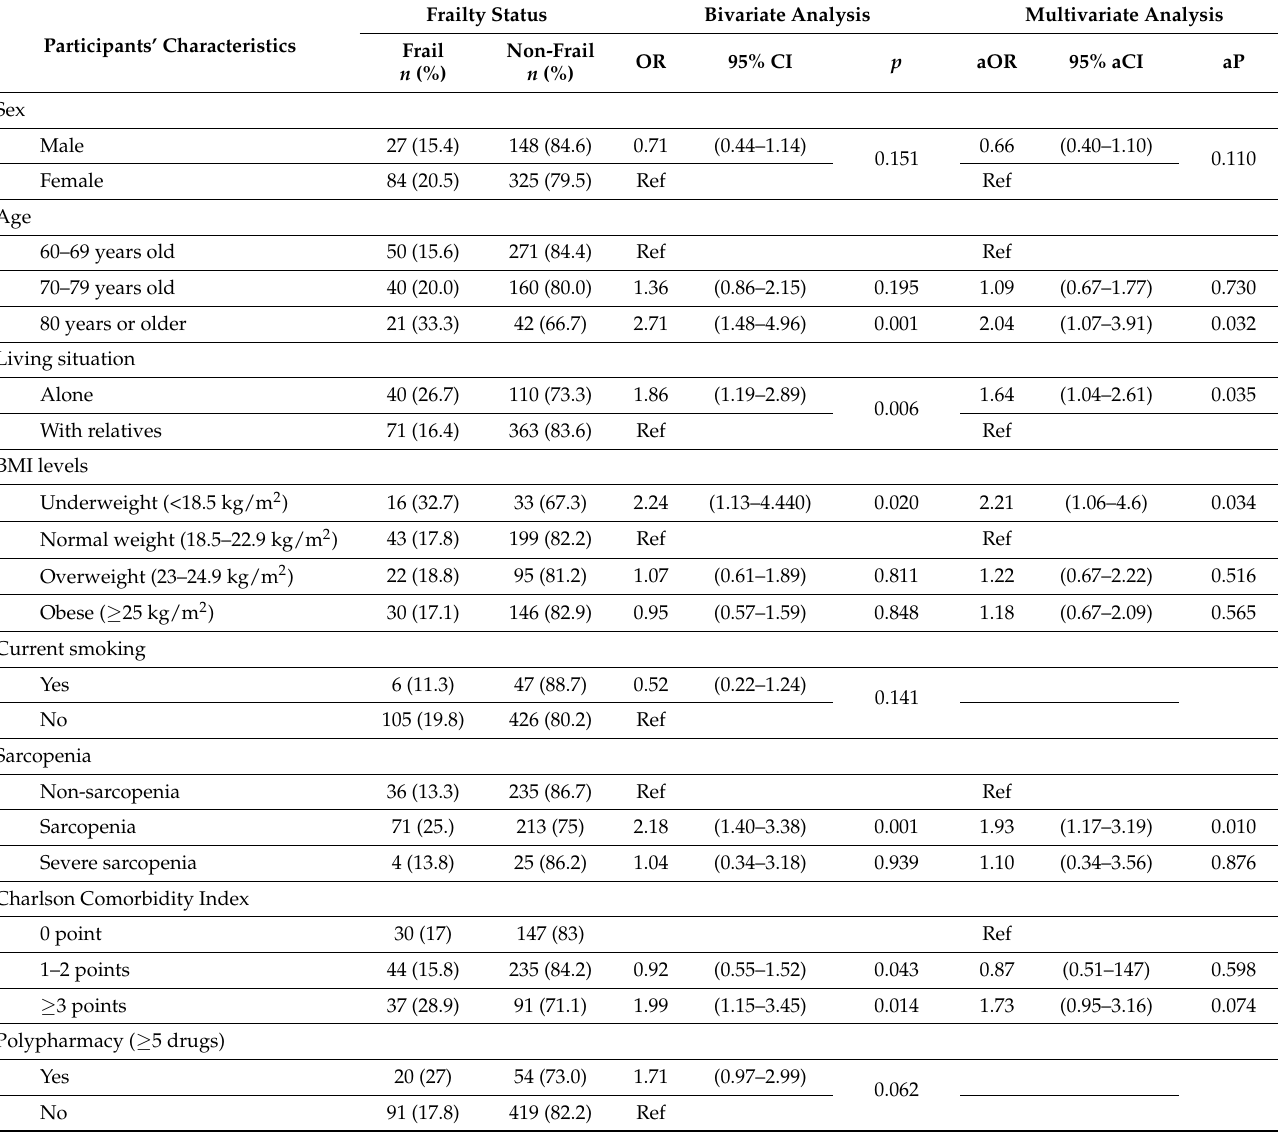
Table 3. Association between frailty status and study sample characteristics ( n =